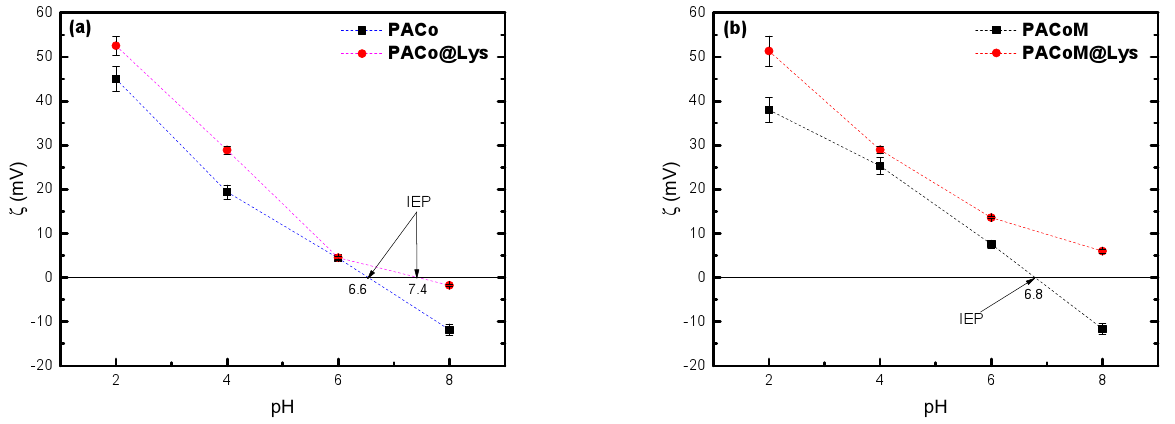
Figure 6. Zeta potential of the nanoparticles as a function of pH for ( a ) PACo–Lys and PACo samples, and ( b ) PACoM and PACoM–Lys samples.